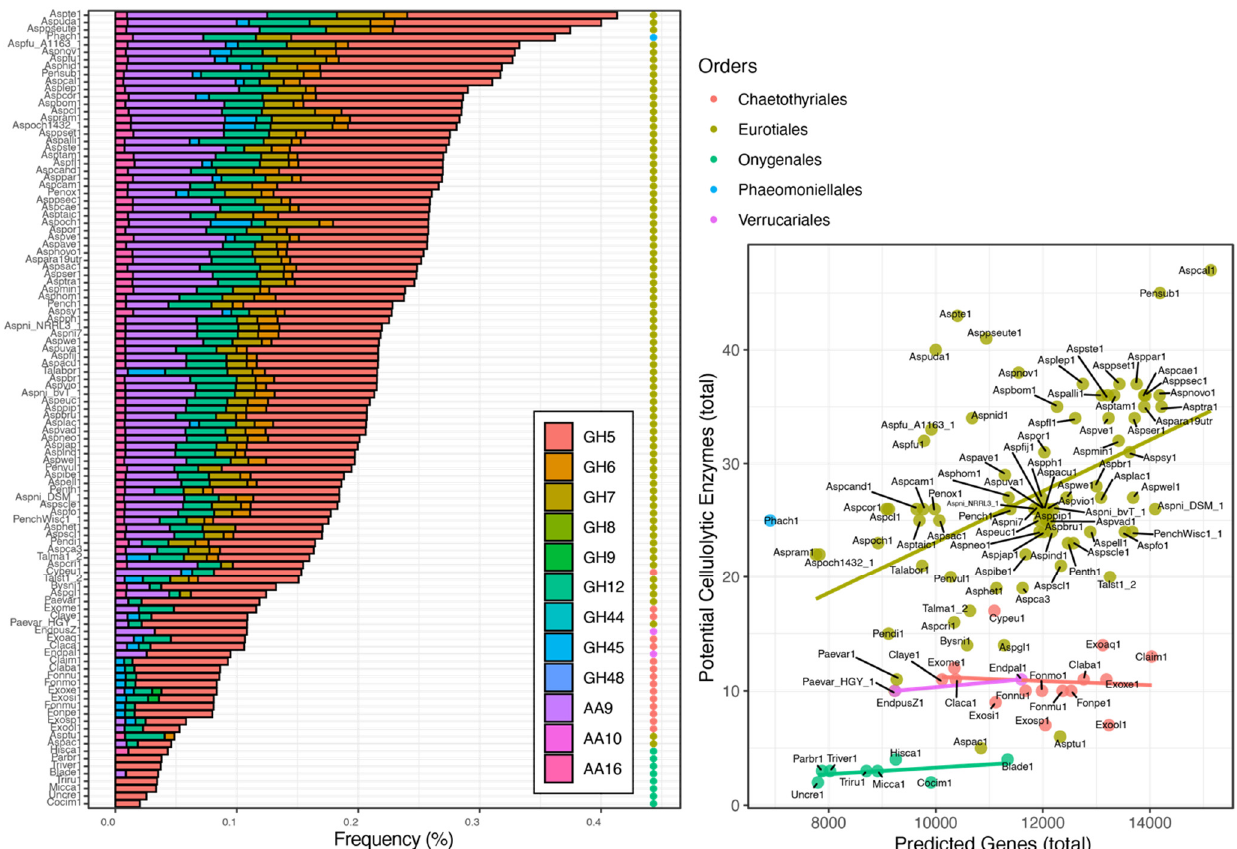
Figure 4. The functional potential for cellulose deconstruction in sequenced genomes from the class Eurotiomycetes ( n = 107). Frequency of the predicted potential cellulases (left) and total number of predicted potential cellulases across orders of Eurotiomycetes (right). Lines depict the linear regression between the predicted cellulases and the predicted number of genes, if correlated (i.e., P Pearson < 0.05).